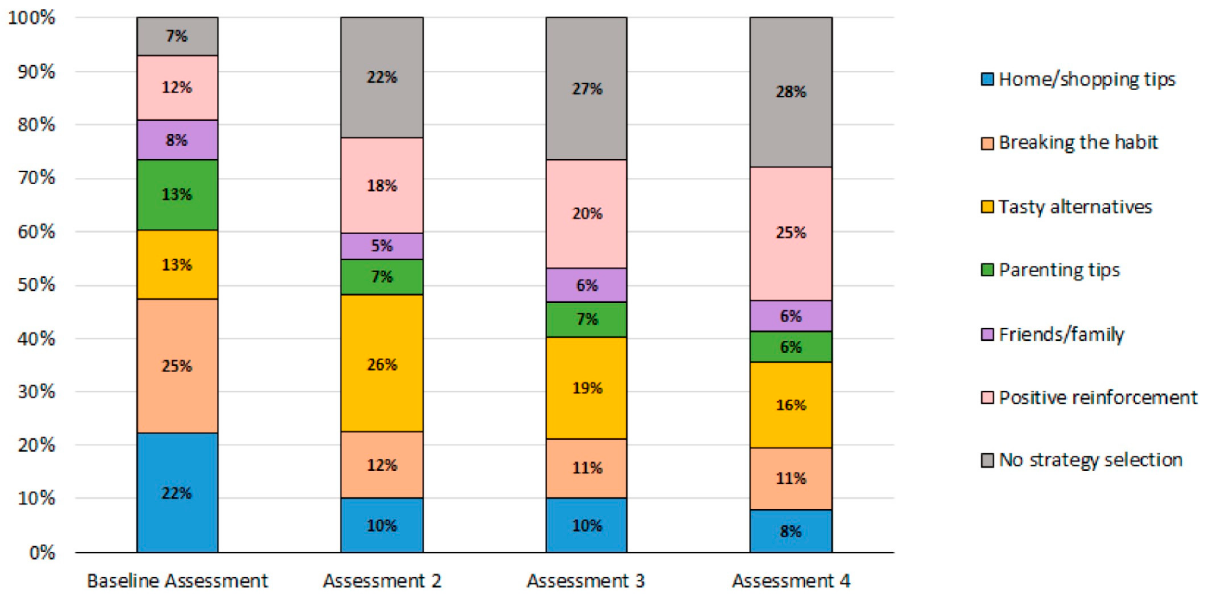
Figure 4. Strategy selections made by enrolled caregivers ( n = 542) from Baseline 1 through Assess- ment 4 2 . 1 At the Baseline Assessment, 14 (3%) of the “no strategy selection” caregivers were those who completed the Baseline Assessment at the second attempt (during Assessment 2), and their strategy selections are included in the Assessment 2 data (Home/shopping tips = 3, Breaking the habit = 4, Tasty alternatives = 1, Parenting tips = 2, Friends/family = 1, Positive reinforcement = 2, Partial responder = 1). 2 Caregivers do not select a strategy at Assessment 5.